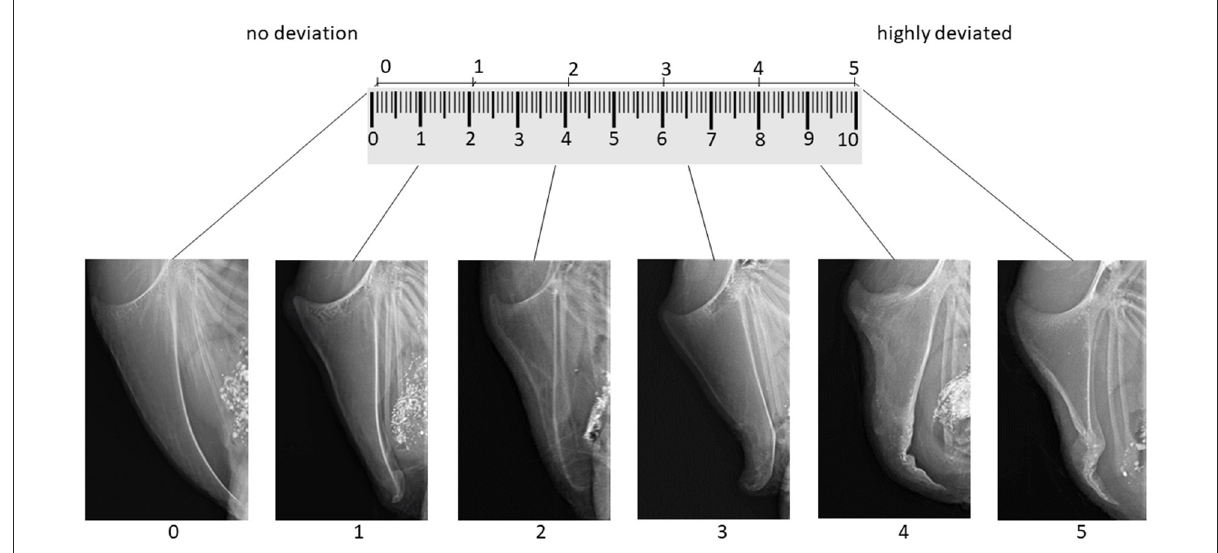
FIGURE1 Tagged visual analog scale for the evaluation of keel bone deviations on x-rays including links to get the original x-ray in full